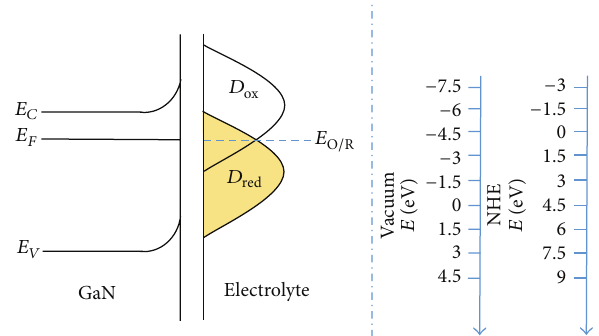
Figure 1: The energy band diagram for the 𝑛 -type GaN/electrolyte interface.